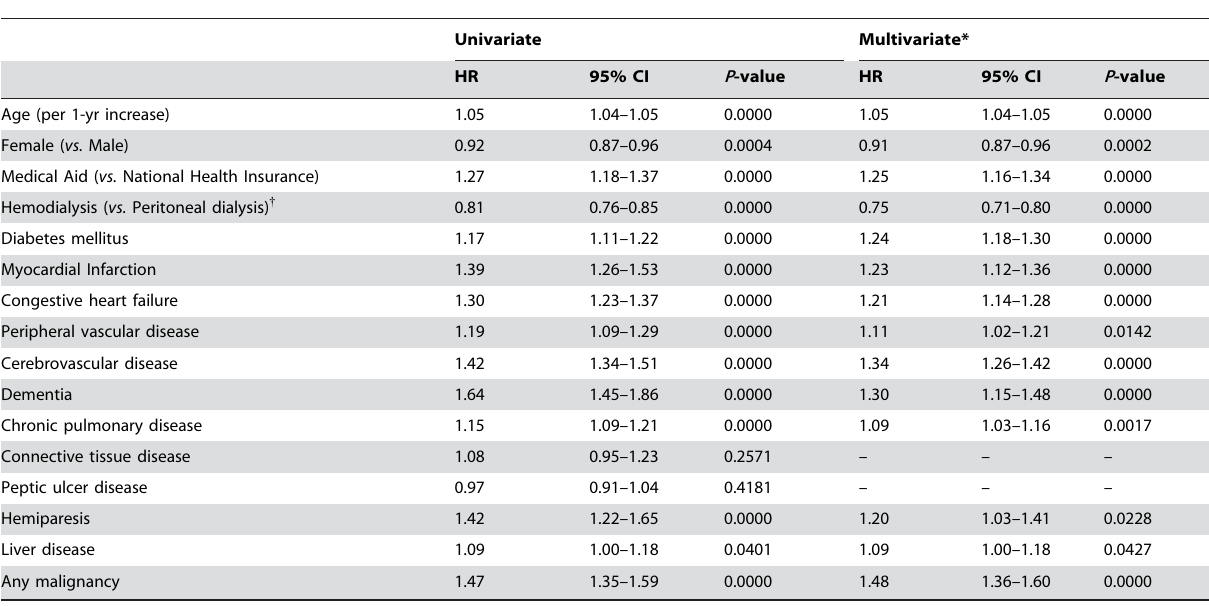
Table 3. Results of the Cox proportional hazards analysis for all-cause